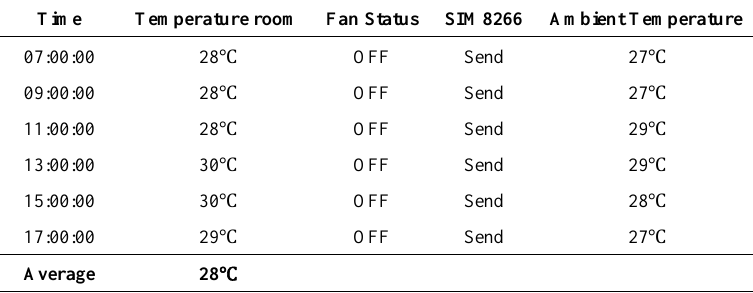
Table 2. Testing of room temperature control in cloudy weather.